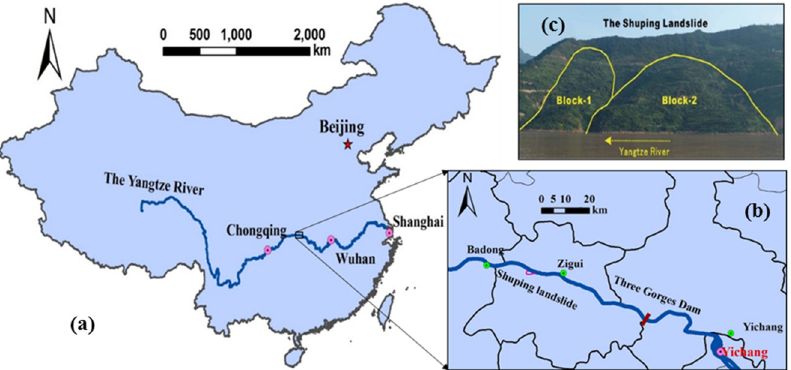
Figure 4. Location of the Shuping landslide in China ( a , b ) and a photo of Shuping landslide taken from opposite bank facing south ( c ) [22].